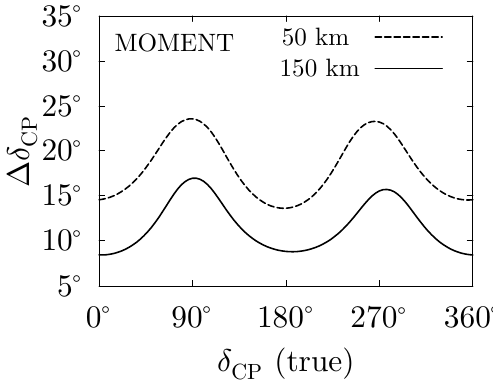
Figure 6. The e(cid:11)ect of the (cid:12)rst oscillation maximum on the precision measurement of (cid:14) CP . The 1 (cid:27) con(cid:12)dence level uncertainty of (cid:14) CP is shown for two baseline lengths, L = 50 km and 150 km, which correspond to the experimental con(cid:12)gurations where MOMENT is optimized for the (cid:12)rst and second oscillation maximum, respectively. The results are independent of the mass